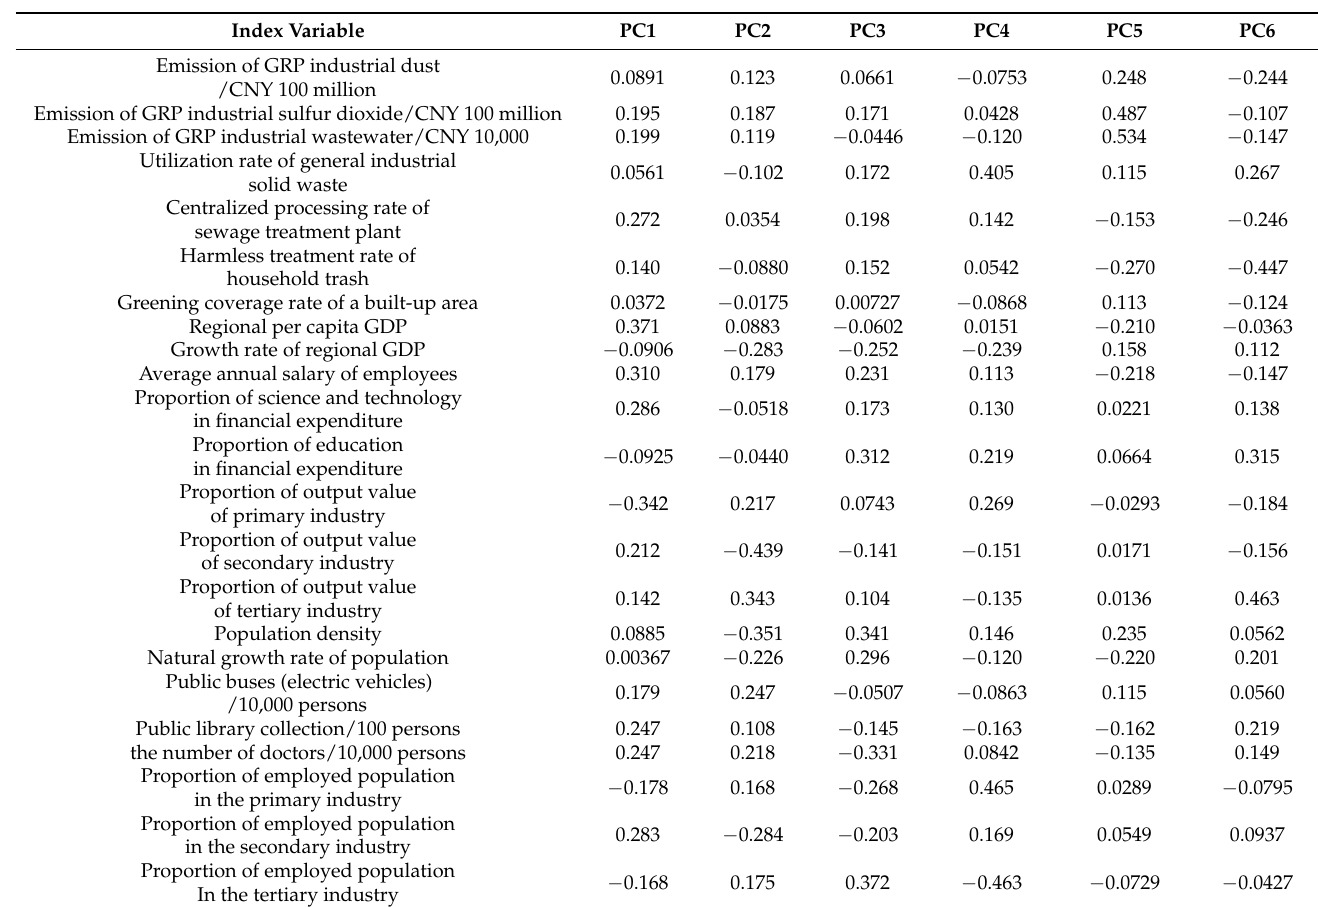
Table 7. Principal component load.